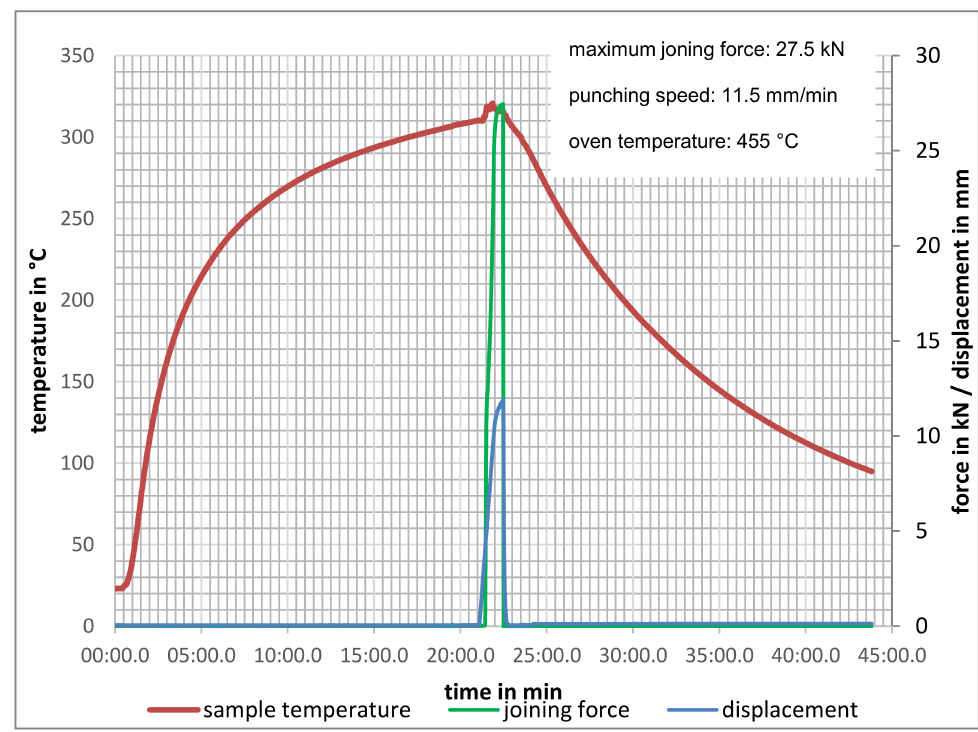
Figure 4. Force, displacement, and temperature graphs of the joining